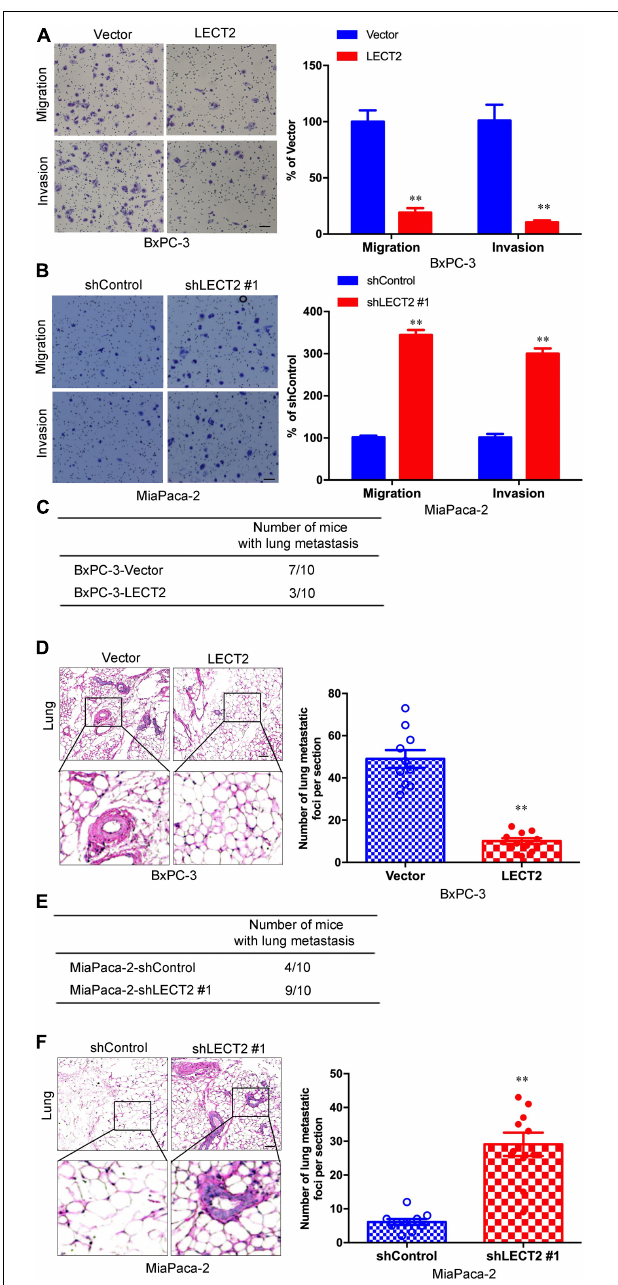
FIGURE 4 | LECT2 inhibits PDAC migration, invasion, and distant lung metastasis. (A,B) Representative images of migration (top) and invasion (bottom) of transformed BxPC-3 (A) and MiaPaca-2 (B) cells described above (left) with corresponding quantifications (right). (C) Number of mice with distant lung metastasis following intravenous injections of transformed BxPC-3 cells as described above. (D) Representative H&E staining images (left) of metastatic lung foci per section from allograft mice described in (C) with corresponding quantifications (right). (E) Number of mice with distant lung metastasis following intravenous injections of transformed MiaPaca-2 cells as described above. (F) Representative H&E staining images (left) of metastatic lung foci per section from allograft mice described in (E) with corresponding quantifications (right). Scale bar = 50 µ m in (A,B) . Scale bar = 200 µ m in (D,E) . ** p < 0 .